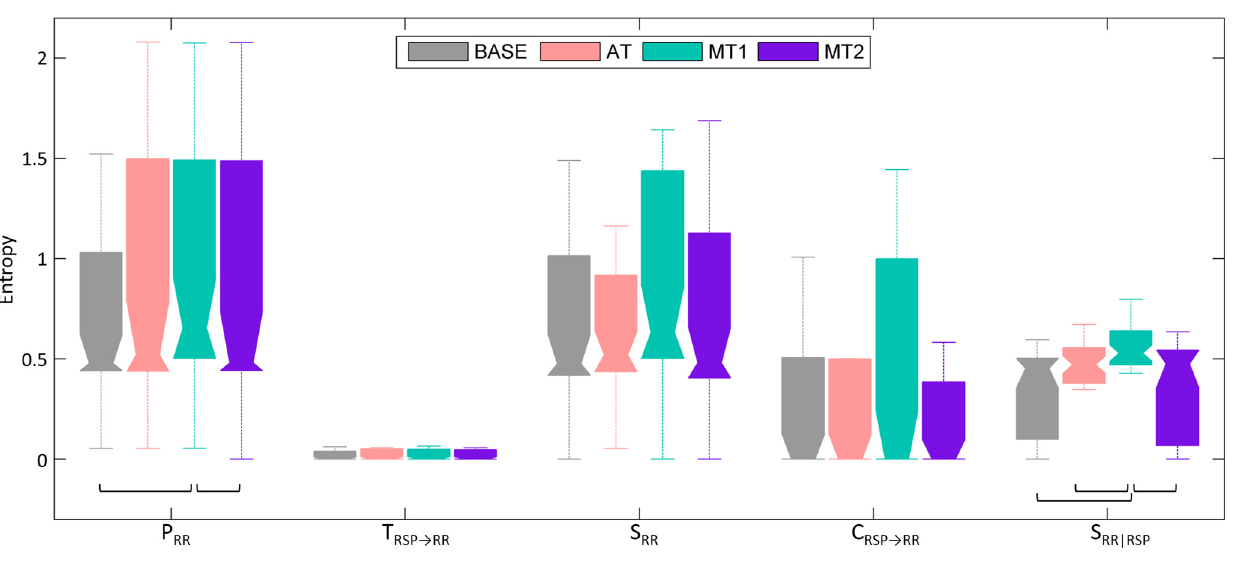
Fig 3. Boxplots of information-theoretic measures P RR ( p < 0.01), T RSP ! RR ( p > 0.05), S RR ( p > 0.05), C RSP ! RR ( p > 0.05) and S RR j RSP ( p < 0.0001), estimated using the nonlinear model-free approach, during baseline (BASE), sustained attention (AT) and the mental stress tasks (MT1 and MT2). The square brackets indicate significant differences between those two mental states as determined by the Friedman test and post hoc